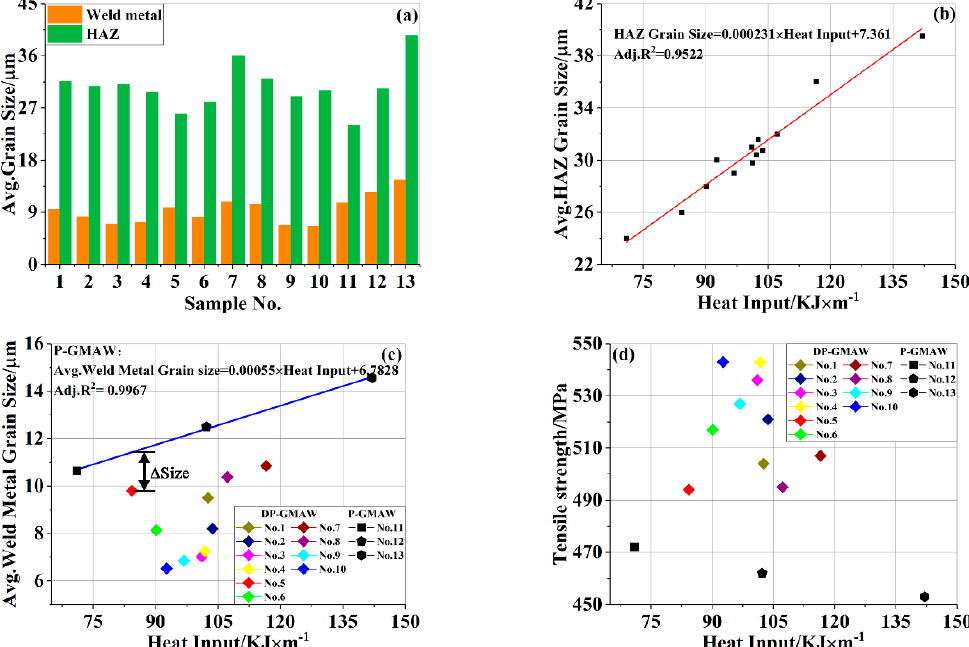
Figure 19. ( a ) Average grain size of weld metal and HAZ; ( b ) grain size of HAZ with different heat input; ( c ) grain size of weld metal with different heat input; ( d ) tensile strength with different heat input.